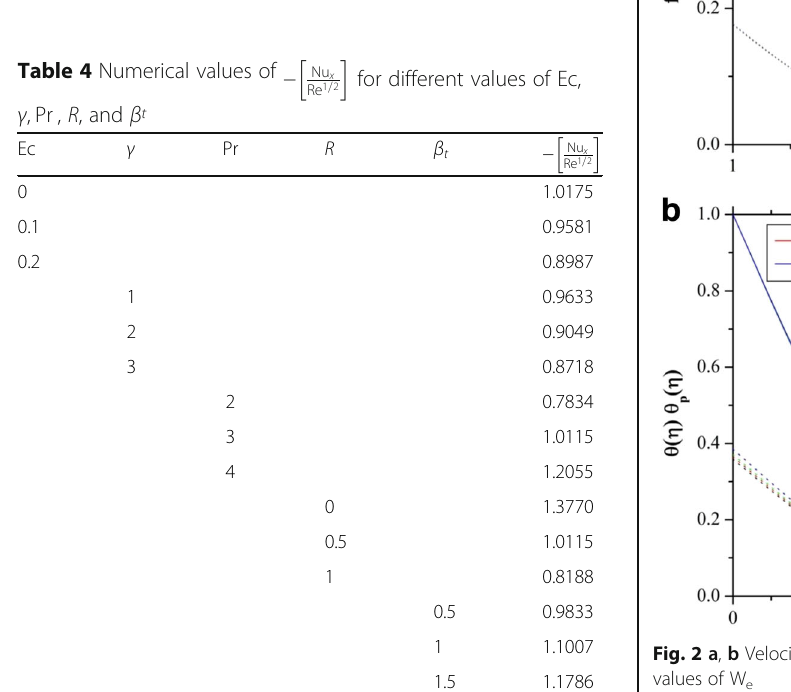
Table 4 Numerical values of − Nu x